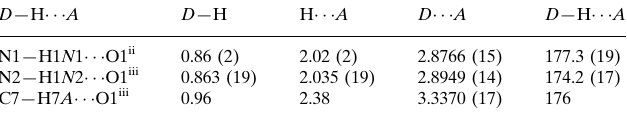
Hydrogen-bond geometry (A˚ , (cid:3)